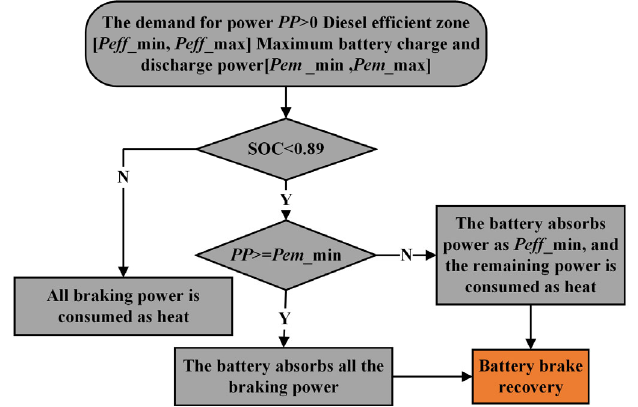
Figure 5. Flow chart of RB strategy when PP < 0.